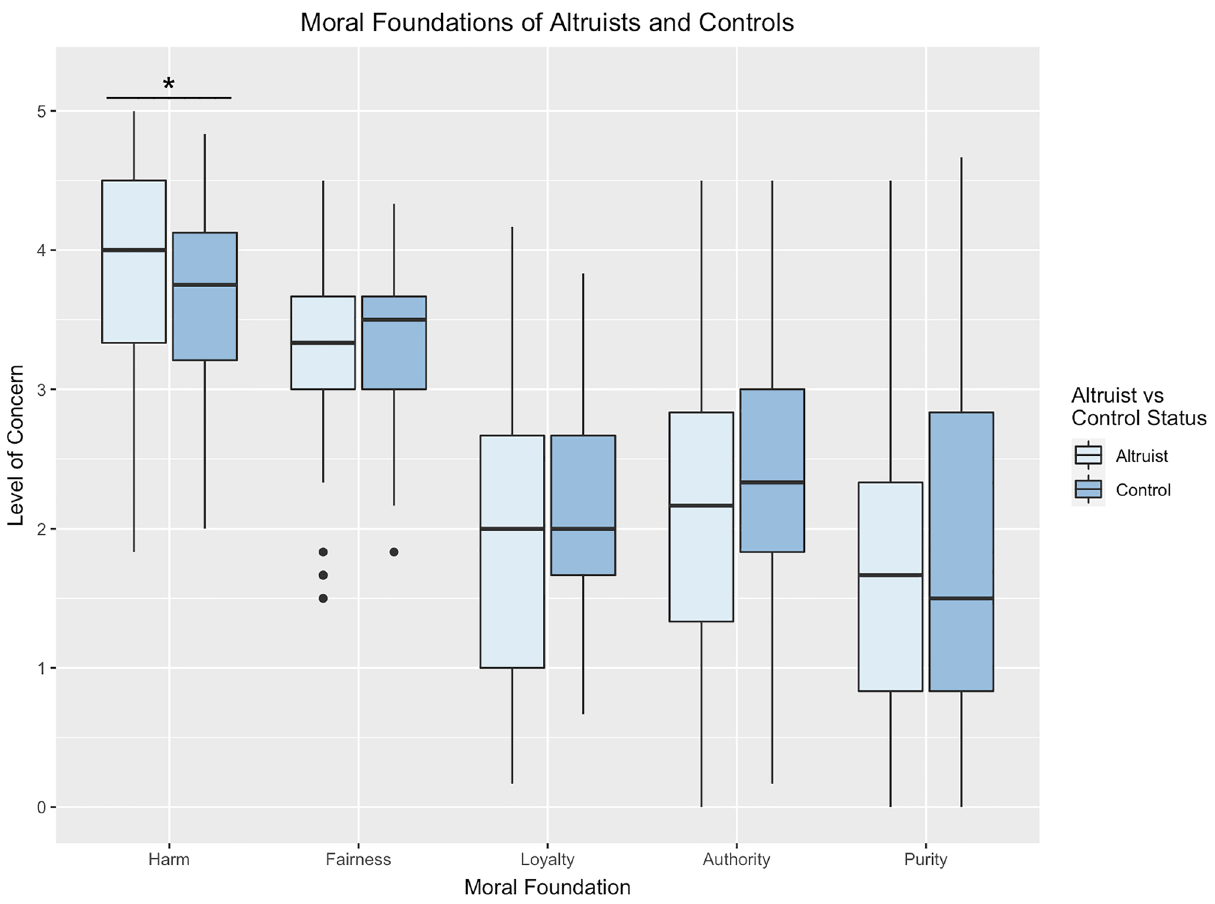
Figure 1. Boxplot of moral foundation scores for altruists and demographically matched controls. Note. * P < .05; ** P < .01; *** P <